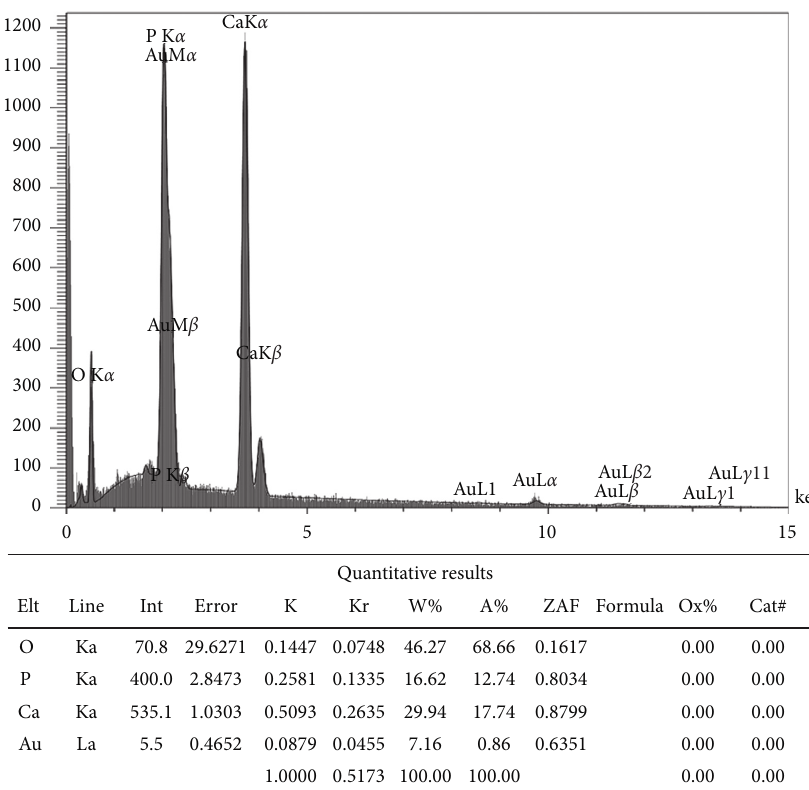
Figure 3: EDXA of the prepared ceramic microparticles. EDXA showed that the weight percentage of calcium was more than phosphate, and the Ca/P ratio (w %) in the ceramic microparticles was 1.8.